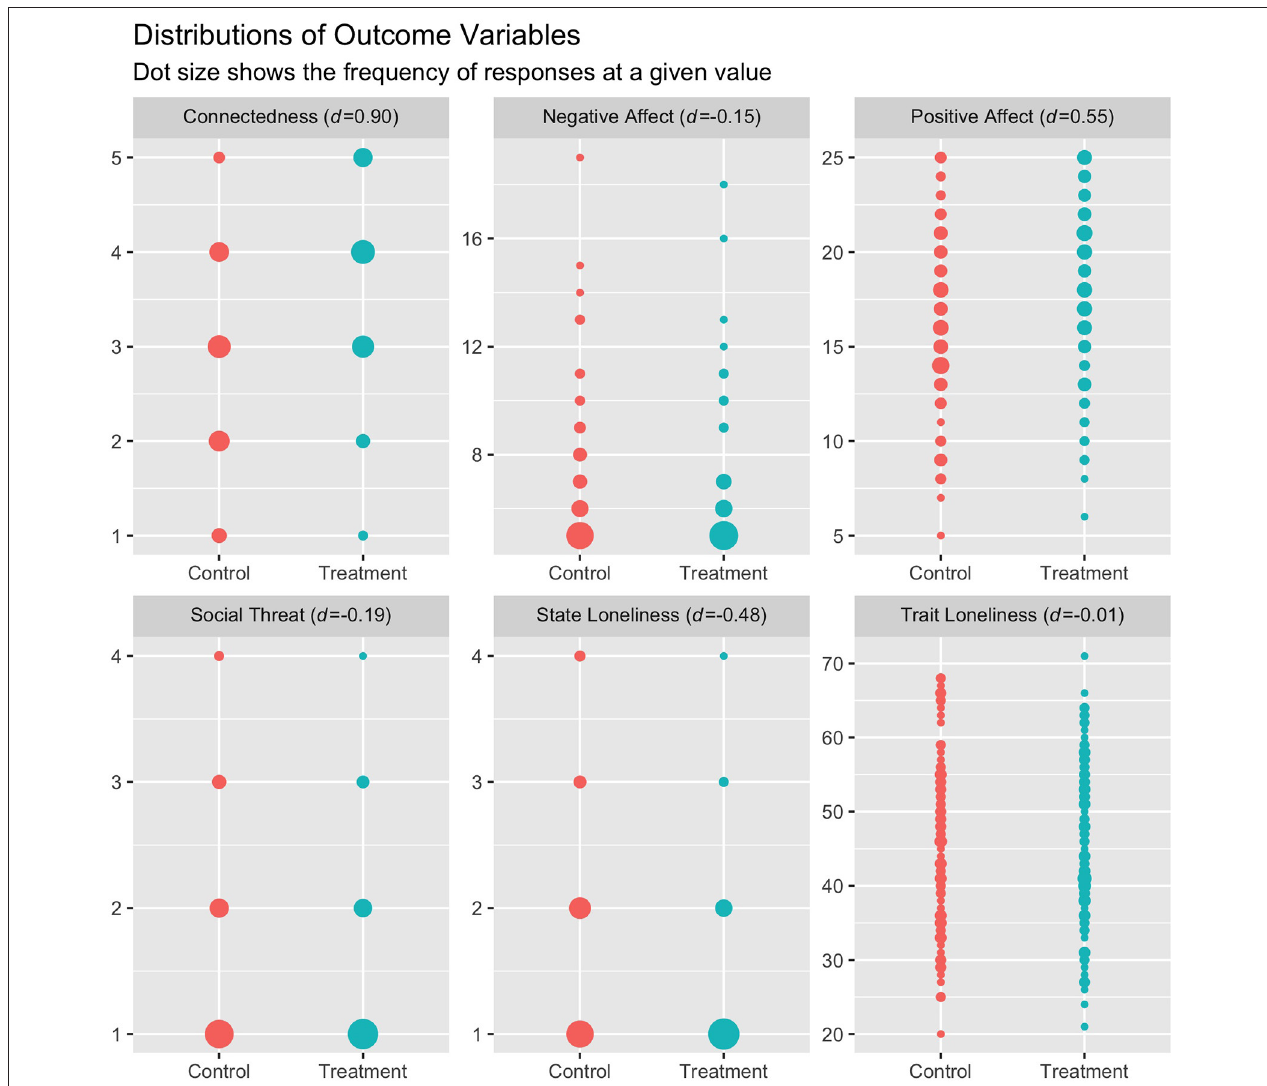
FIGURE 1 | Value frequencies of outcome variables across conditions. We measured outcomes directly after the live video experience for all outcomes except trait loneliness, which we measured 4 weeks later. The sample size was 249 for all outcomes except trait loneliness, which was 199. d refers to Cohen’s D, measuring the difference in outcome means across conditions at